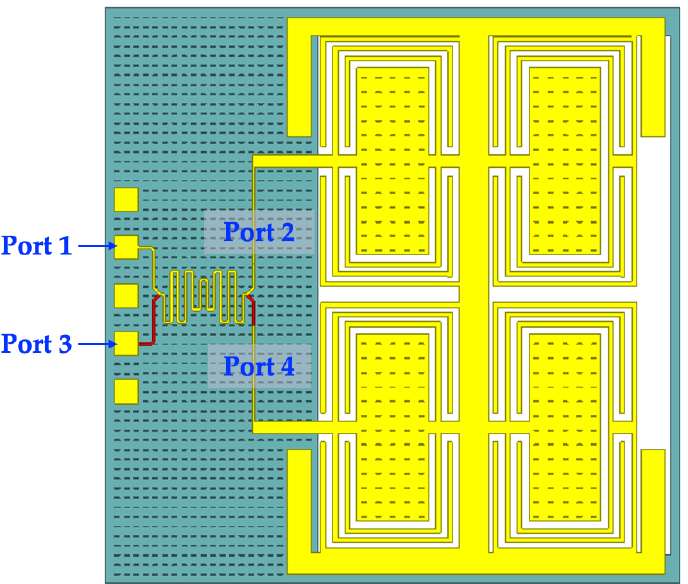
Figure 16. Geometry of the proposed linearly polarized antenna and coupler: top view.